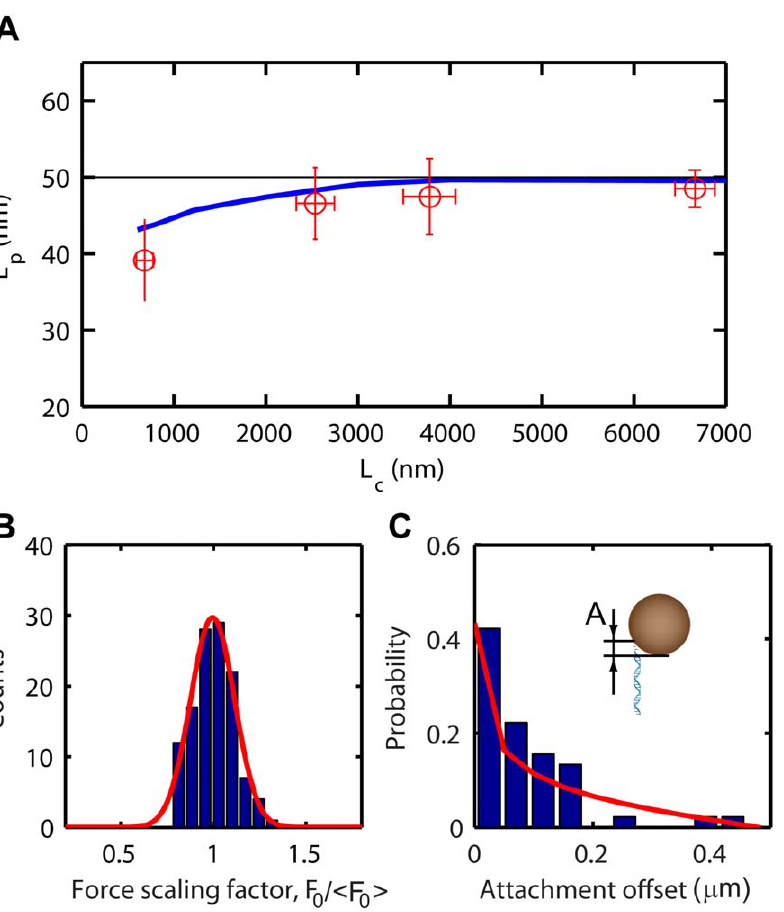
Figure 5. Ensemble analysis of DNA mechanics. A Multiplexed measurements of the persistence length, L p , versus the contour length, L c , for DNA molecules with different length (2.2 kb (N=19), 7.3 kb (N=16), 11.9 kb (N=36) and 20.1 kb (N=9)). The data is compared to predictions from finite-difference modeling in the absence of thermal fluctuations (black line) and in the presence of thermal fluctuations (blue line). B Histogram of extracted force-calibration factor F 0 / , F 0 . (N=120). C Ensemble study of attachment position of the DNA on the bead. The histogram shows the distribution of DNA-bead attachment offsets (N=45). Red line is the expected distribution (see Fig. S5 and eq. 3).